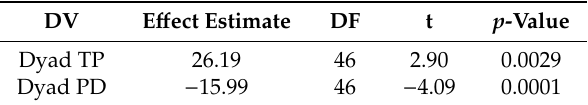
Table 3. Statistical results, Study 2.